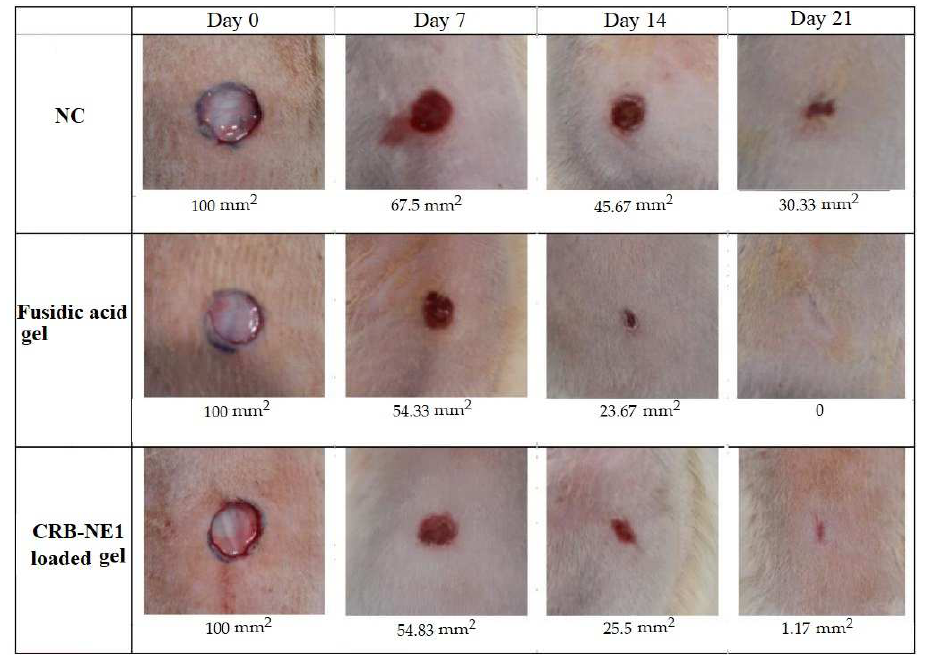
Figure 6. Photographs of wound healing and wound size (mm 2 ) at different time intervals in excision wound model in rats.